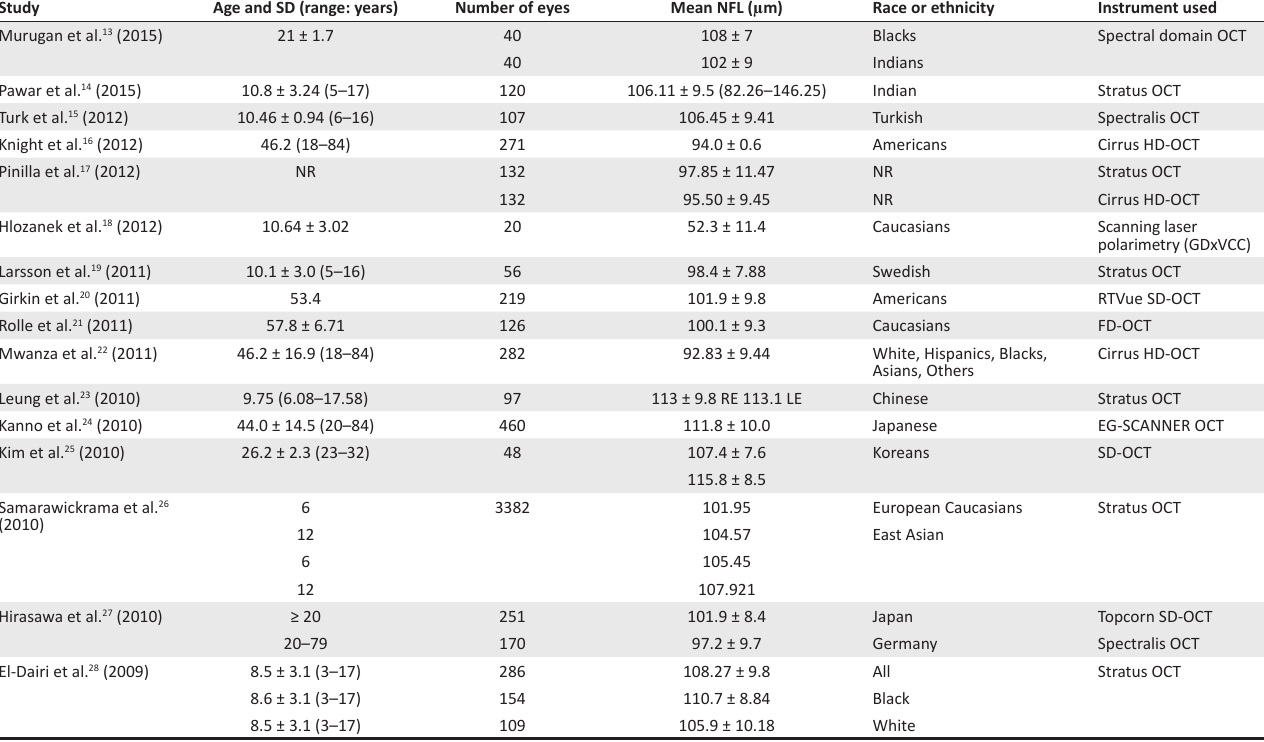
TABLE 1: Study characteristics and mean thickness of the retinal nerve fibre layer in different ethnic populations. All studies included both males and females. Study Age and SD (range: